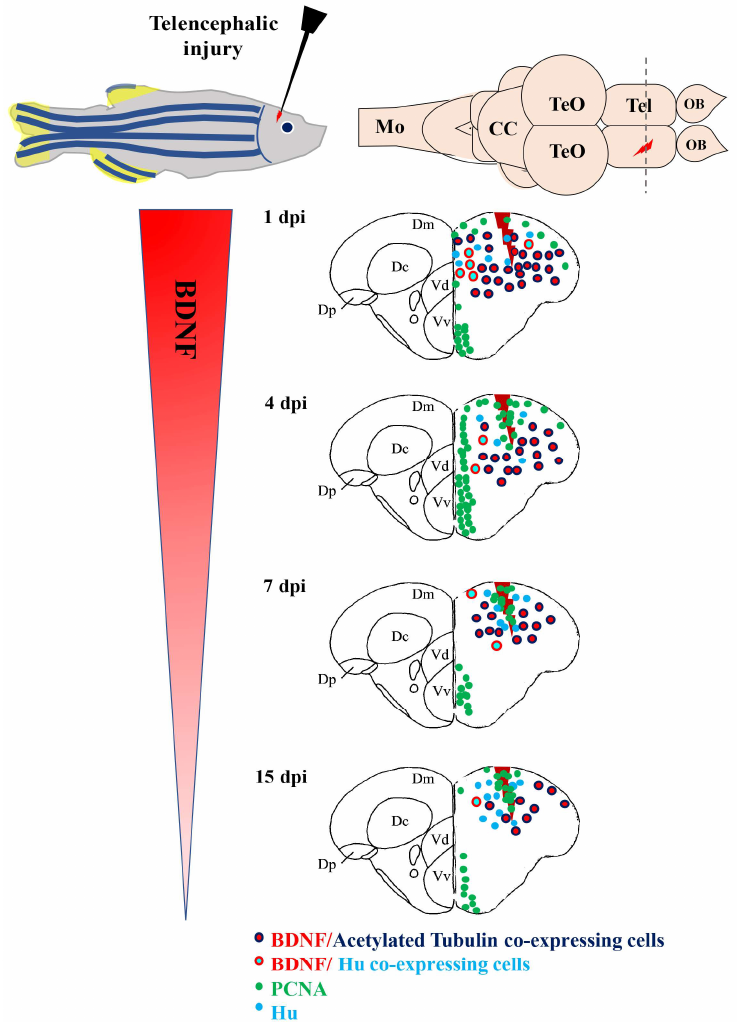
Figure 2. BDNF mRNA distribution in cross sections of the zebrafish telencephalon after injury. Cells containing BDNF mRNA (red dots) are young (Hu positive, azure dots) and mature (Acetylated-Tubulin, blue dots) neurons. In several areas, they resulted close to proliferating cells (green dots). Abbreviations: CC: Cerebellar body; Dc: Central area of dorsal telencephalon; Dm: Medial area of dorsal telencephalon; Dp: Posterior area of dorsal telencephalon; Mo: Medulla oblongata; OB: Olfactory bulb; Tel: Telencephalon; TeO: Optic tect: Vd: Dorsal nucleus of ventral telencephalic area; Vv: Ventral nucleus of ventral telencephalic